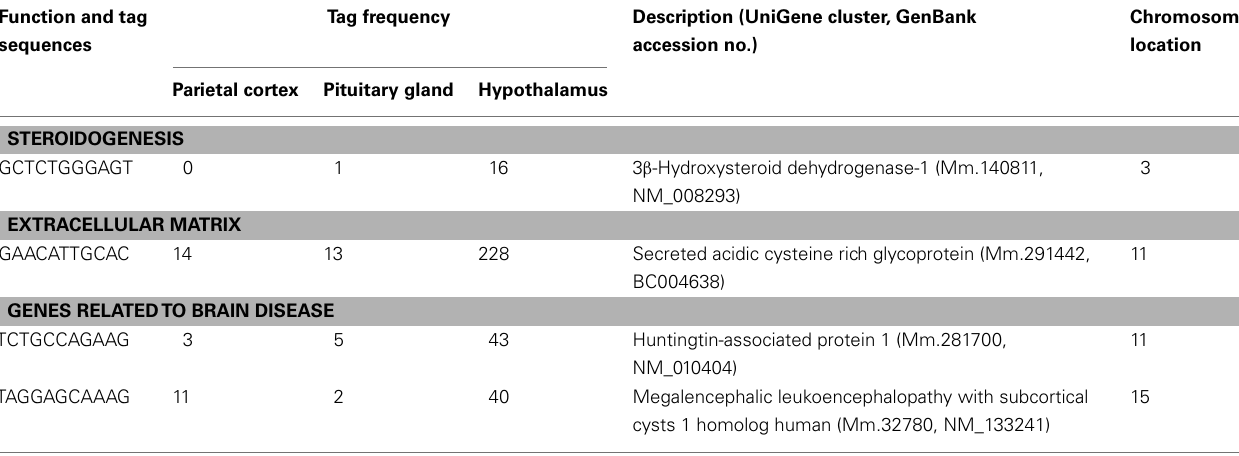
Table 2 | Other transcripts preferentially expressed in the hypothalamus.